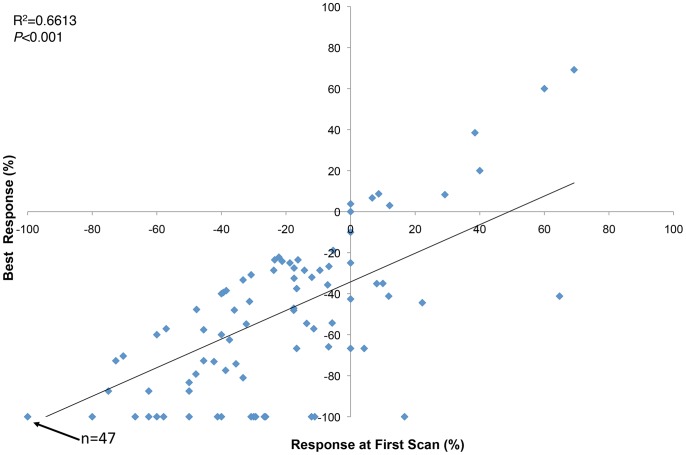
Correlation of the response of individual metastases at first scan versus best response (N = 135).